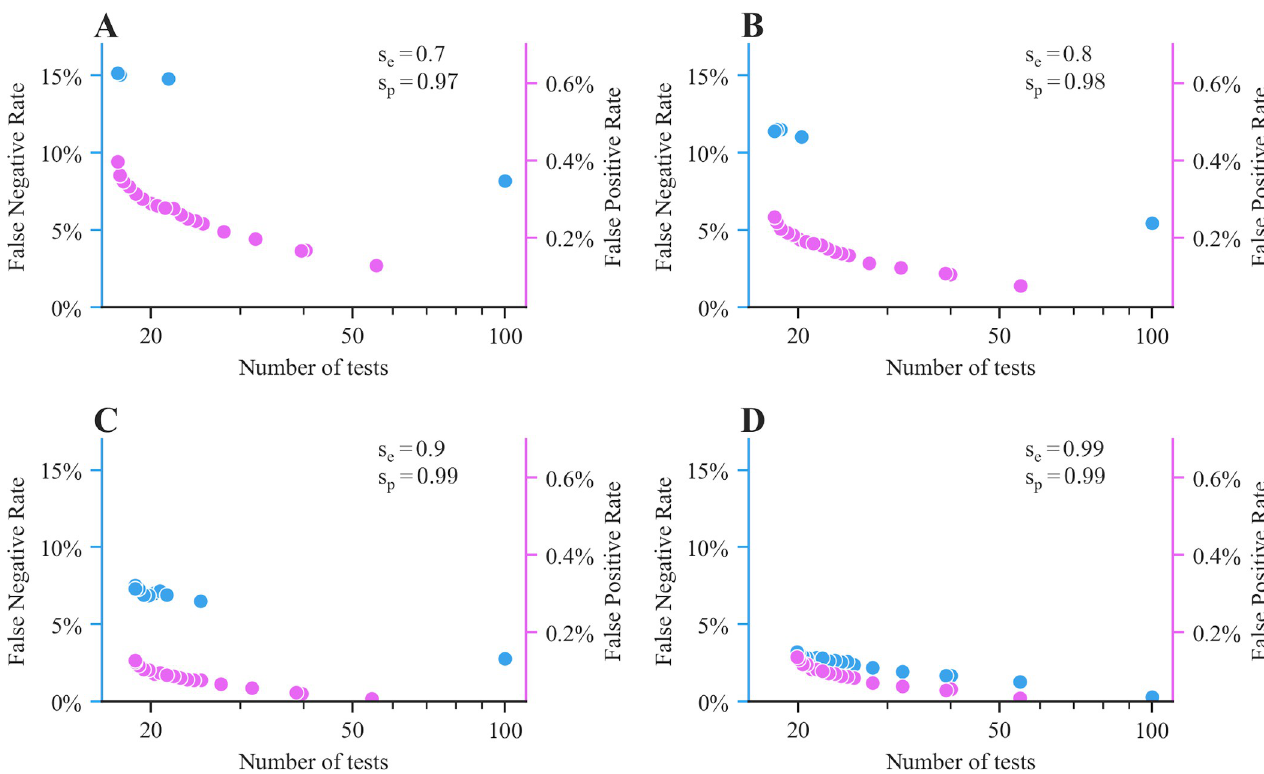
Fig 3. Average number of tests, false negative rate and false positive rate achieved by our method under different values of the parameters λ 1 and λ 2 and different levels of specificity s e and sensitivity s p . In each panel, we either penalize the false negative rate (i.e., we vary λ 1 and set λ 2 = 0) or the false positive rate (i.e., we vary λ 2 and set λ 1 = 0). Accordingly, for the former, we show the false negative rate vs average number of tests (in blue) and, for the latter, we show the false positive rate vs average number of tests (in purple). Here, we set the number of contacts to N = 100 and sample the number of positive infections from a truncated negative binomial distribution with reproductive number R = 2.5 and dispersion parameter k = 0.1. In each experiment, we estimate averages using 10,000 samples. For the exact sizes of the optimal pools corresponding to each point in the figure, refer to S4–S11 Tables.